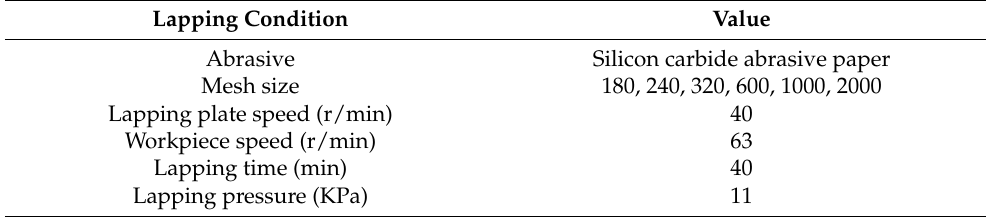
Table 1. Lapping parameters for fiber-reinforced PEEK lapping machinability analysis. Lapping Condition